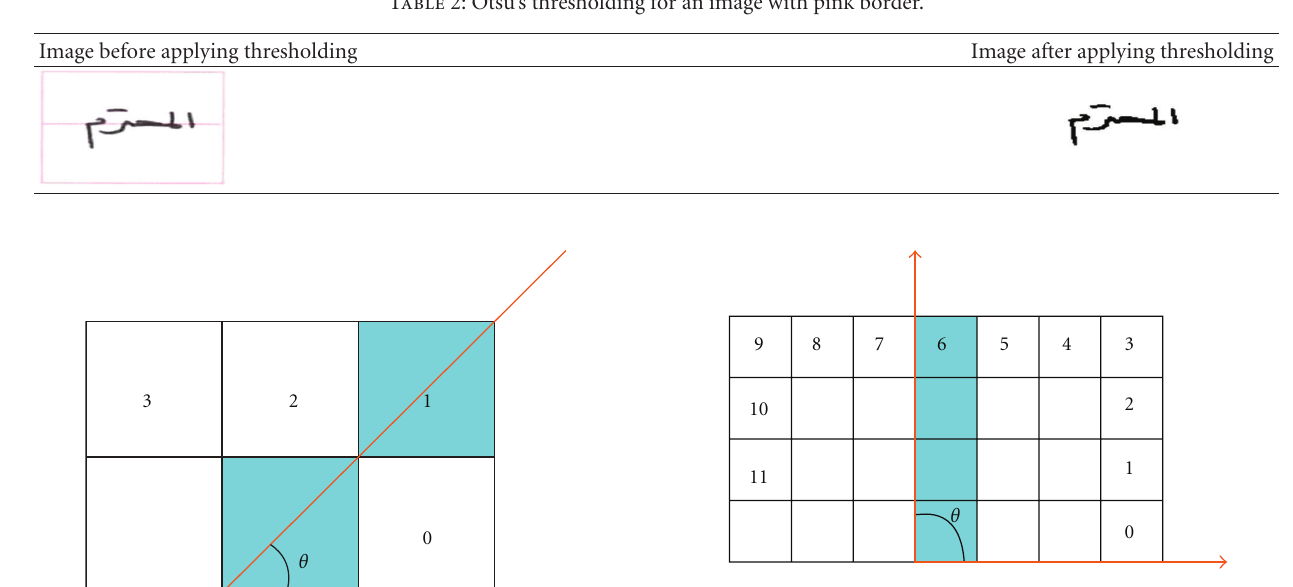
Figure 5: Extraction of the edge-direction distribution using 12 angles.